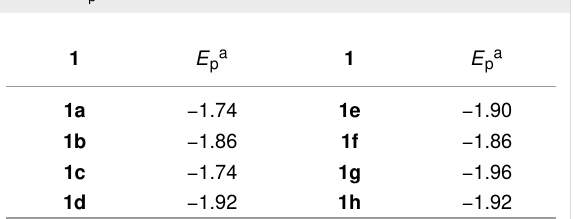
Table 3: E p values of 1a – h derived from